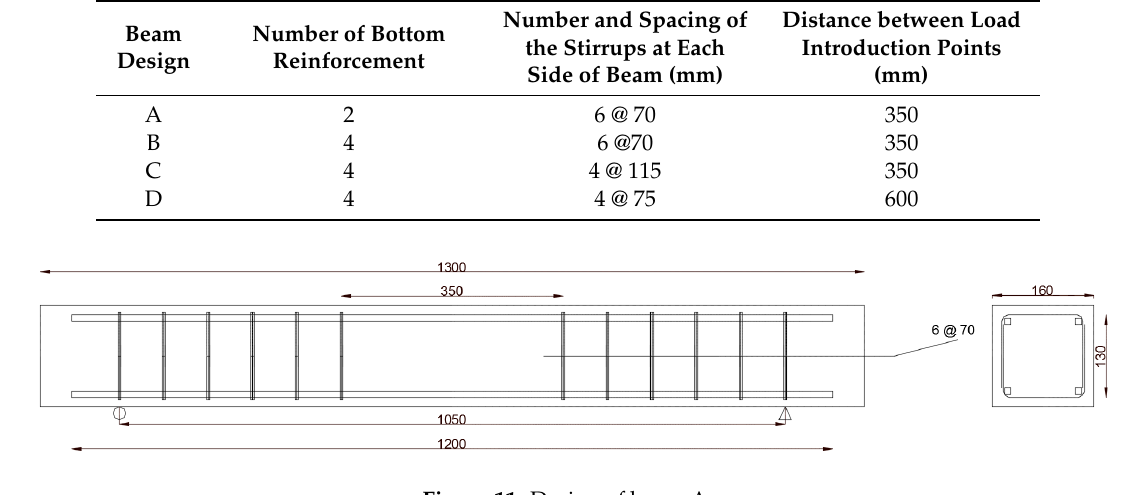
Table 3. Details of the bamboo composite reinforced concrete beams.